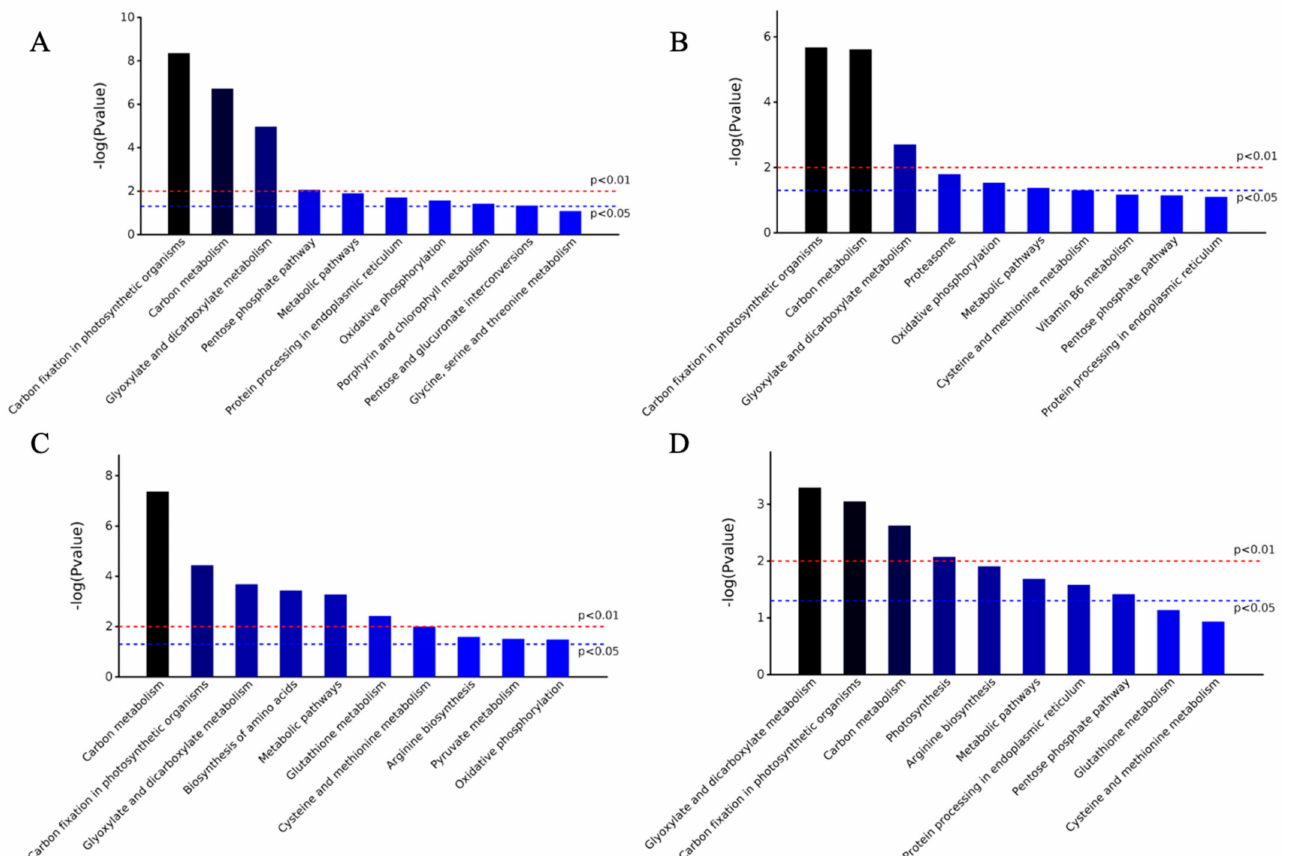
Figure 5. KEGG analysis of four groups of proteins. The figure shows the top ten entries according to a significant degree. From left to right was the following − log( p -value) from a large to a small array, which meant that the closer to the left side, the more significant. The vertical axis represents − log ( p -value). The red line indicates that p = 0.01, while the blue line indicates that p = 0.05. Only when the column is higher than the red line or blue line, does its corresponding metabolic pathway have significant meaning. ( A ) M-M, ( B ) M-SA, ( C ) R-M, ( D )